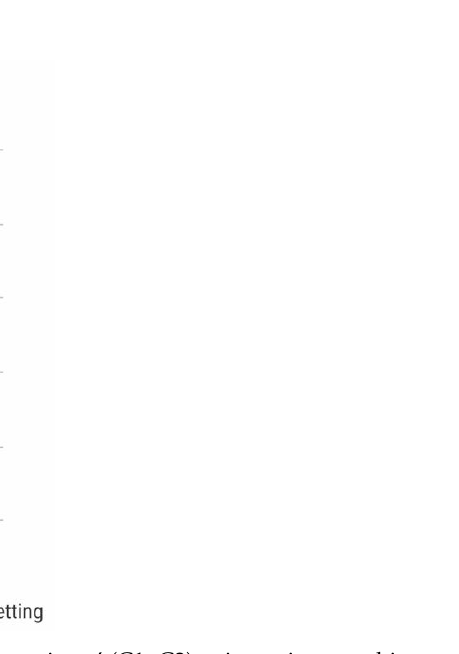
Figure 5. Descriptive analysis of RMC’s receivers’ (C1, C2) gain setting to achieve transparency ( n = 14).